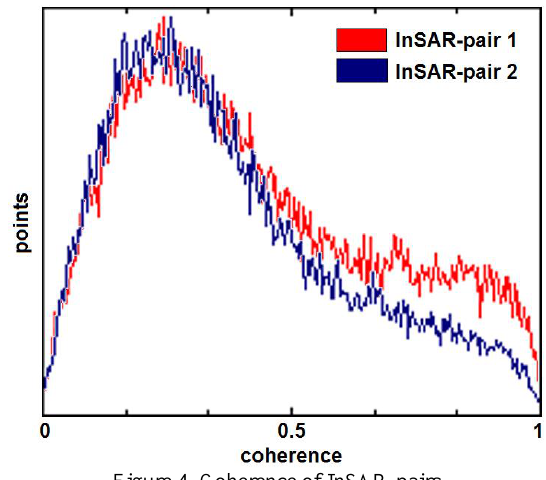
Figure 4. Coherence of InSAR-pairs The generated interferometric DSMs in UTM 33° WGS84 are shown in Figure 5a and 5b. Considering terrain and non-terrain formations, it is easily seen that the representation performance of DSM 1 are superior to DSM 2.